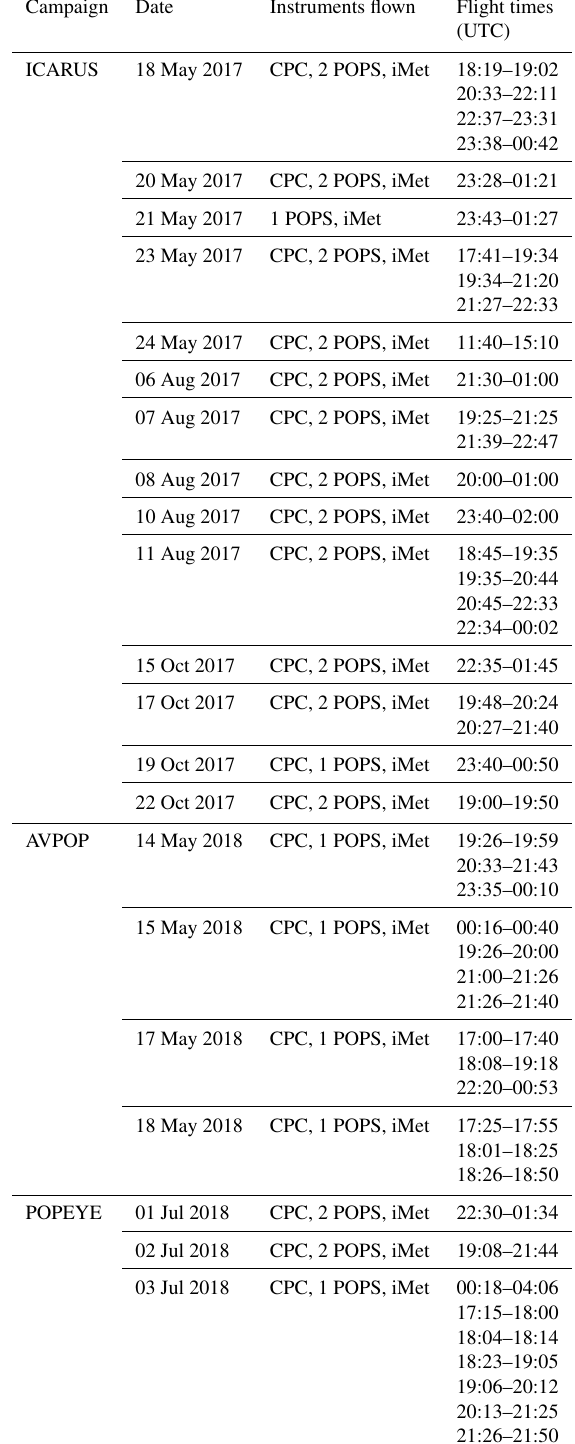
Table 1. Dates, times, and instruments flown during TBS flights presented in this study from the Inaugural Campaigns for ARM Re- search using Unmanned Systems (ICARUS), Aerosol Vertical Pro- filing at Oliktok Point (AVPOP), and Profiling at Oliktok Point to Enhance Year of Polar Prediction (YOPP) Experiments (POPEYE) flight campaigns at